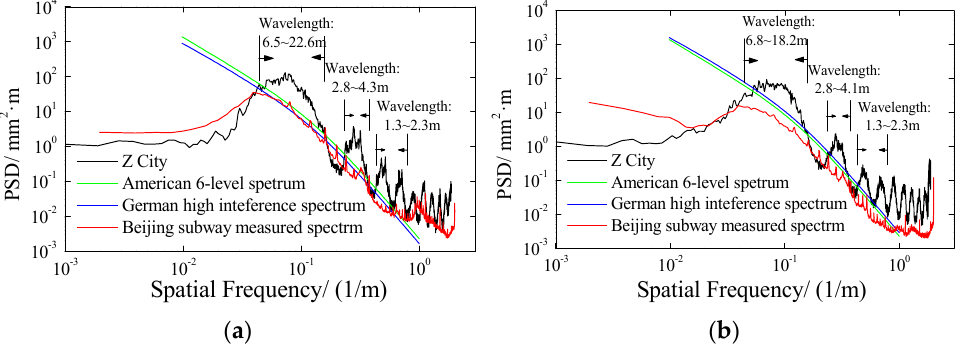
Figure 3. Comparison of track irregularity spectra: ( a ) the comparison of the PSD of the level irregularity; ( b ) the comparison of the PSD of the alignment irregularity.